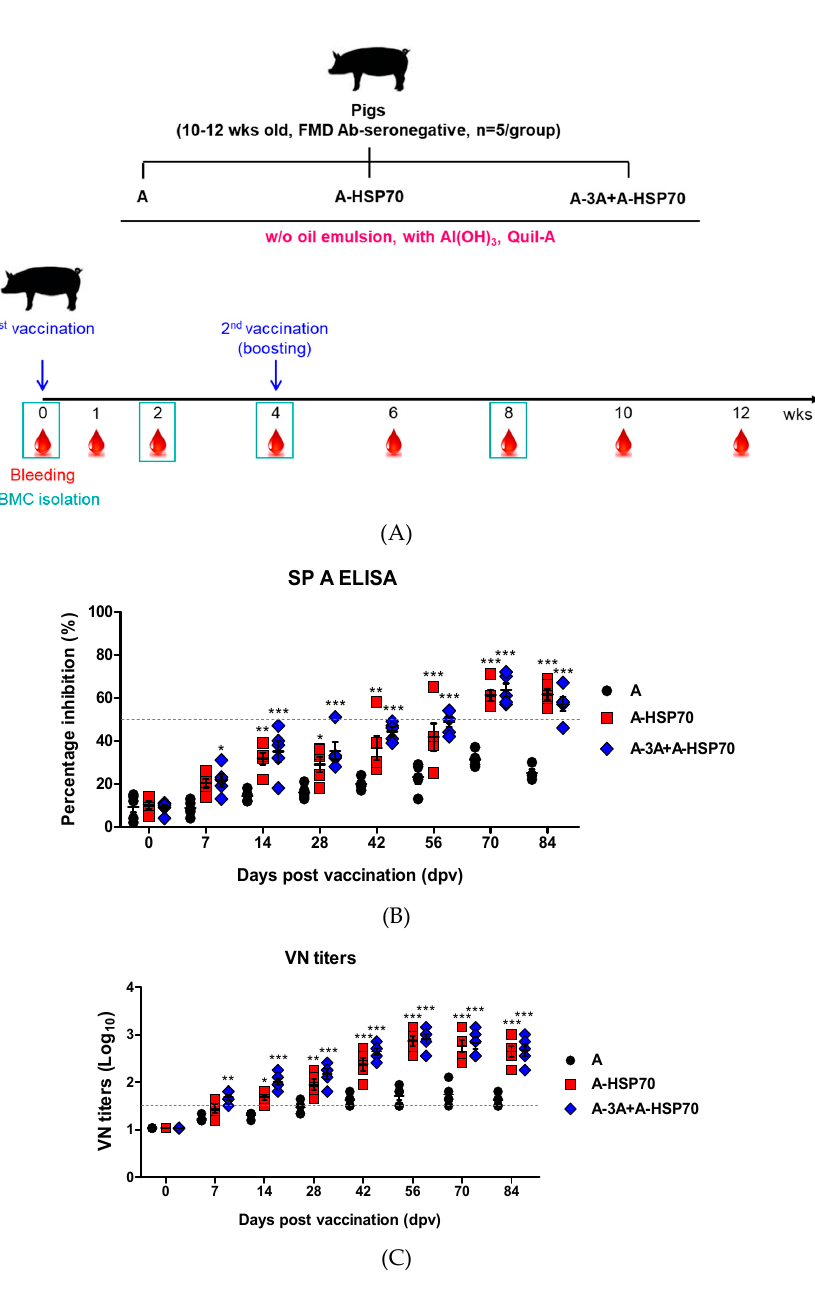
Figure 4. A-3A and A-HSP70 mediated-immune response in pigs. For the pig experiments, FMD antibody-seronegative animals were used (the pigs were 10–12 weeks old). Pigs were divided into 3 groups ( n = 5/group). Pigs were administrated oil emulsion free-test vaccines, including A-HSP70 antigen alone, or combined A-3A and A-HSP70 antigens based on their positive control composition. A positive control group of pigs received 15 μ g (1 dose for cattle and pig use) naïve A antigen, without ( w / o ) oil emulsion, 10% Al(OH) 3 , and 150 μ g Quil-A. The vaccination was performed twice at a 28-day interval, and 1 ml vaccine (1 dose) was injected via a deep intramuscular route at the animals’ necks. Blood samples were collected at 0, 7, 14, 28, 42, 56, 70, and 84 dpv in pigs for the serological assays and at 0, 14, 28, and 56 dpv for PBMC isolation. ( A – C ) represent: ( A ) the strategy for this study; ( B ) antibody titers by SP A ELISA; ( C ) VN titers. The data represent the means ± SEM of triplicate measurements ( n = 5/group). Statistical analyses were performed using two-way ANOVA with Bonferroni correction. * p < 0.05; ** p < 0.01; *** p < 0.001.